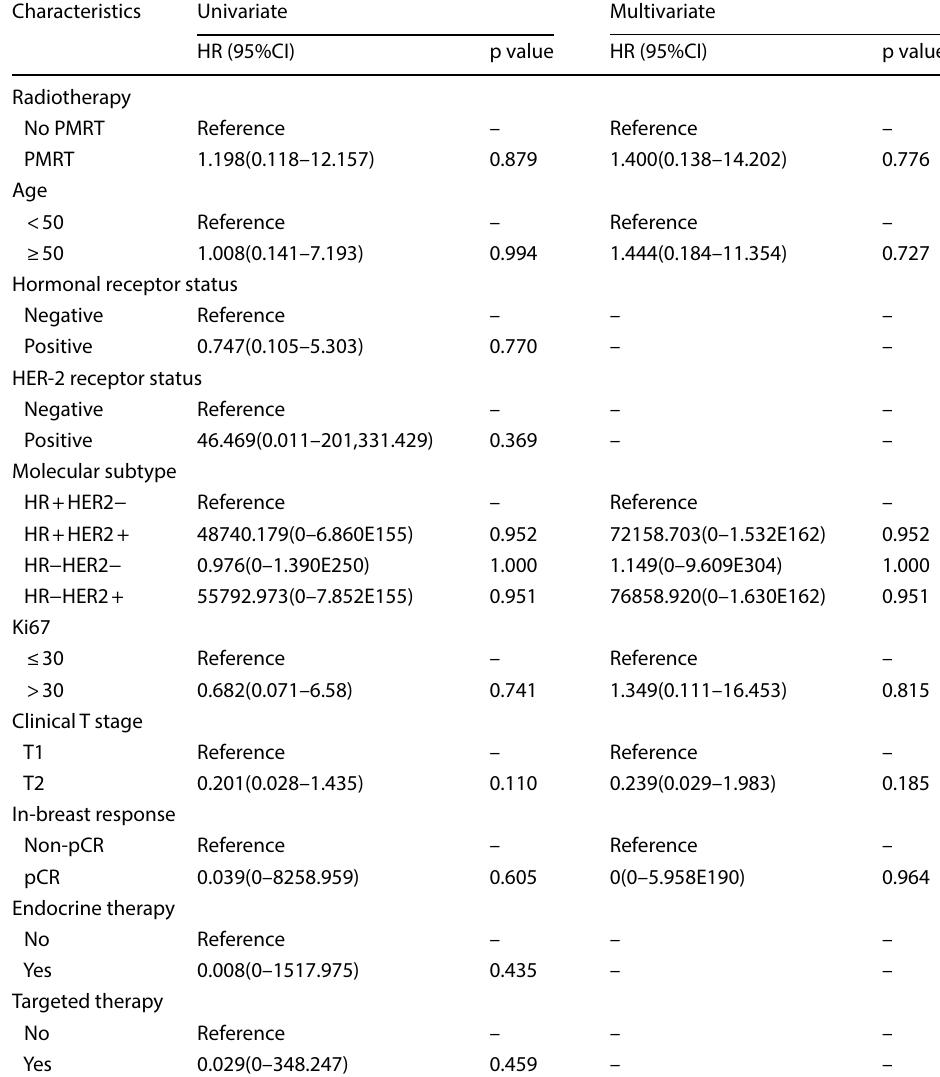
Table 3 Univariate and multivariate analyses of overall survival for all included